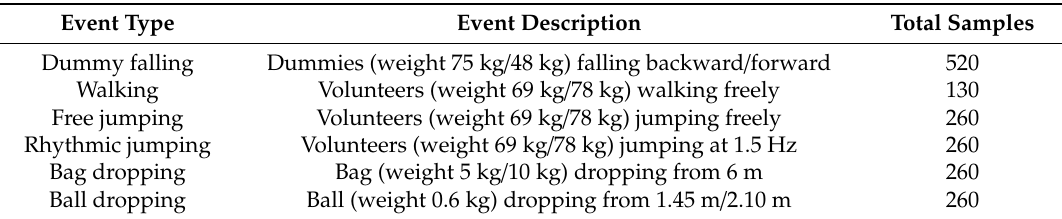
Figure 4. Experiment Setup.